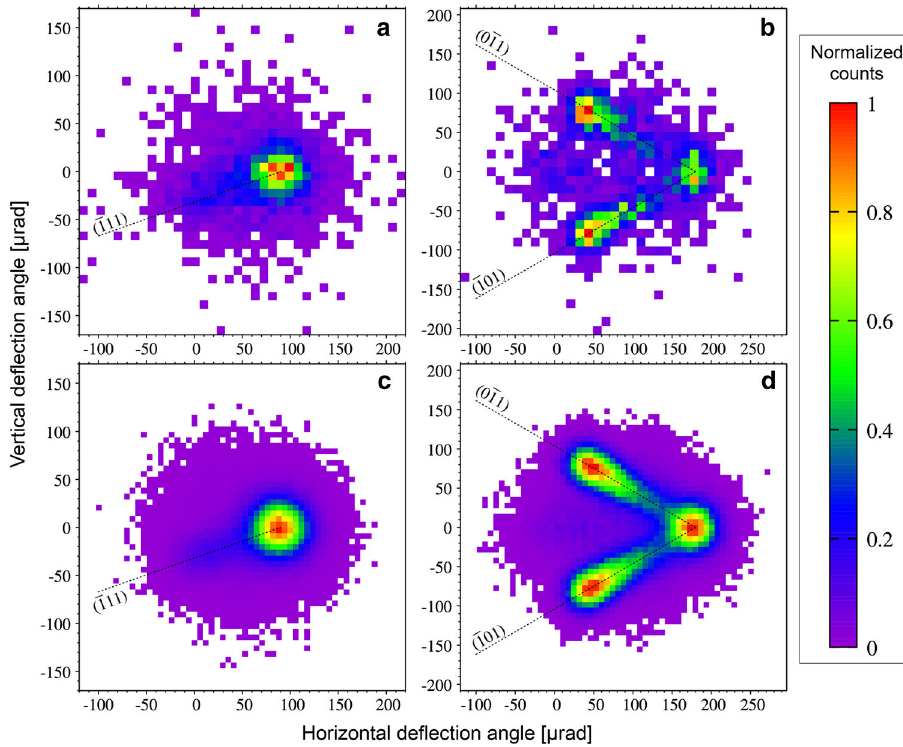
Fig. 10 Experimental ( a , b ) and simulated ( c , d ) angular distribution of 120 GeV/ c positrons after passage through 2 mm long Si crystals, aligned with the (cid:2) 110 (cid:3) ( a , c ) and (cid:2) 111 (cid:3) ( b , d ) axis, bent with curvature radii equal to 22.22 m ( a , c ) and 11.11 m ( b , d ). The black dotted lines identify the skew planes